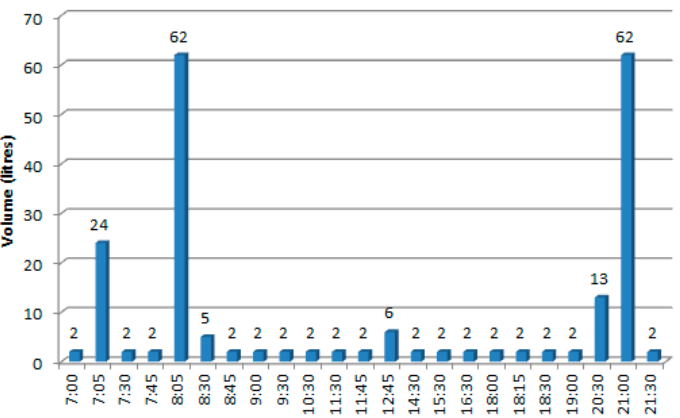
Figure 2. Hot water (60 °C) demand profile based on hot water use of the average European